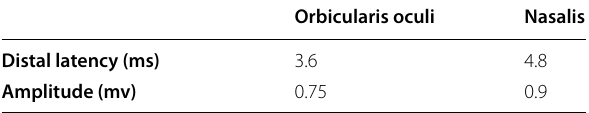
Table 2 The cutoff values of the electrophysiological parameters of the studied facial nerves branches (orbicularis oculi & nasalis)